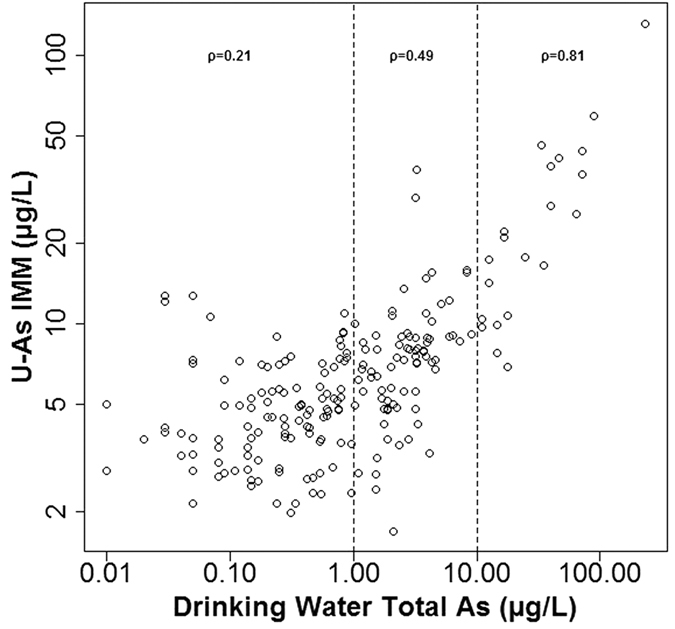
Log-log plot of U-AsIMM vs PWS drinking water As divided into drinking water exposure levels.Variables from Fig. 3c plotted on log scale axes to show contrasting exposure-response relationships of participants exposed to different concentrations of As in drinking water. Spearman’s correlation coefficients (ρ) are displayed for the different drinking water As ranges.